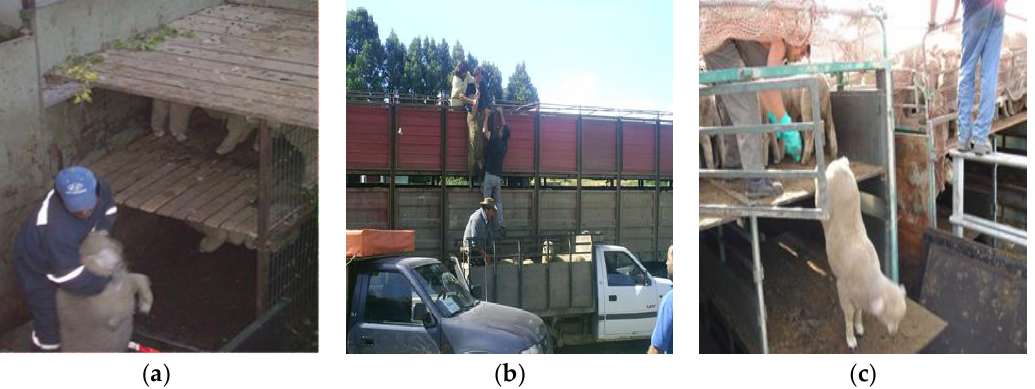
Figure 3. ( a ) Loading sheep using a wooden ramp; ( b ) truck with metallic adjustable pens and double flooring, also showing the metallic loading ramp.